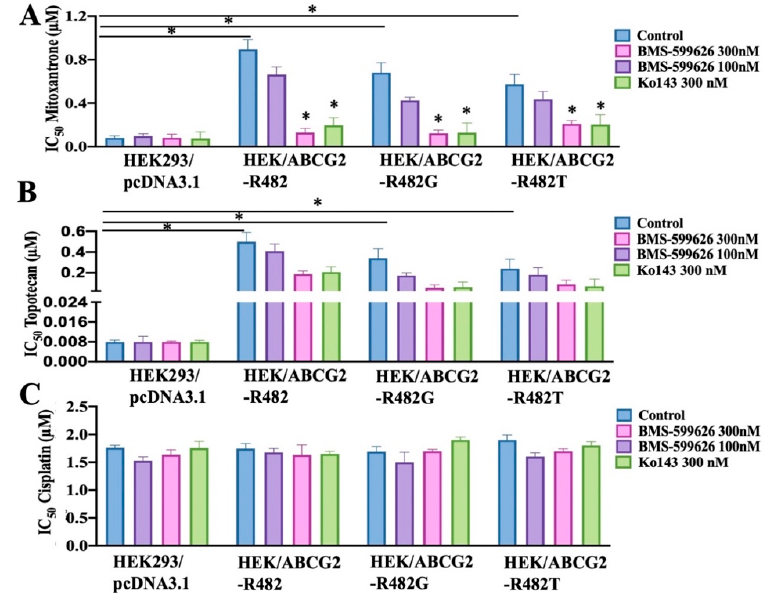
Figure 3. Effect of BMS-599626 on MDR in transfected cell lines overexpressing mutant ABCG2. ( A ) The IC 50 of mitoxantrone in HEK293/pcDNA3.1 and wild-type HEK/ABCG2-R482, mutant HEK/ABCG2-R482G, and HEK/ABCG2-R482T cells with or without BMS-599626 or Ko143, ( B ) the IC 50 of topotecan in HEK293/pcDNA3.1 and wild-type HEK/ABCG2-R482, mutants HEK/ABCG2-R482G, and HEK/ABCG2-R482T cells with or without BMS-599626 or Ko143, ( C ) the IC 50 of cisplatin in HEK293/pcDNA3.1 and wild-type HEK/ABCG2-R482, mutant HEK/ABCG2-R482G, and HEK/ABCG2-R482T cells with or without BMS-599626 or Ko143. Mean values from three independent experiments are given and error bars indicate SD. (*) indicates p < 0.05 compared to control group.